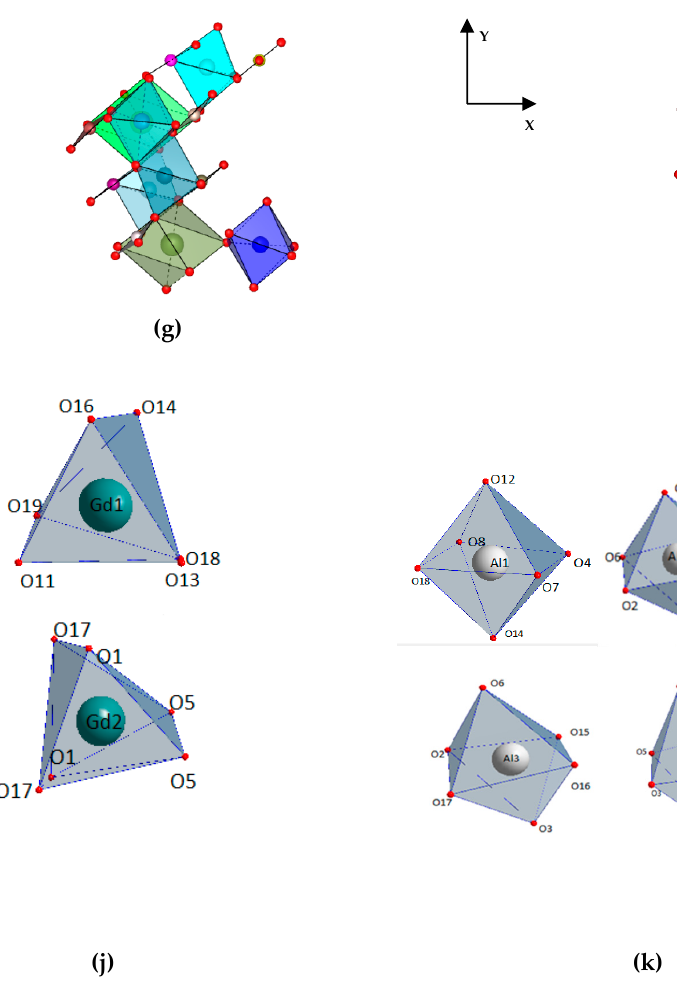
Figure 9. The unit cell of the LnM 3 (BO 3 ) 4 structure (space group C 2) projected onto the ( a ) XZ, ( b ) XY, ( c ) YZ planes; Combination of the coordination polyhedra projected onto the ( d ) XZ, ( e ) XY, ( f ) YZ planes; Combination of selected coordination polyhedra projected onto the ( g ) XZ, ( h ) XY, ( i ) YZ planes; Coordination polyhedra for the ( j ) Ln1 and Ln2 , ( k ) M1–M5 , ( l )